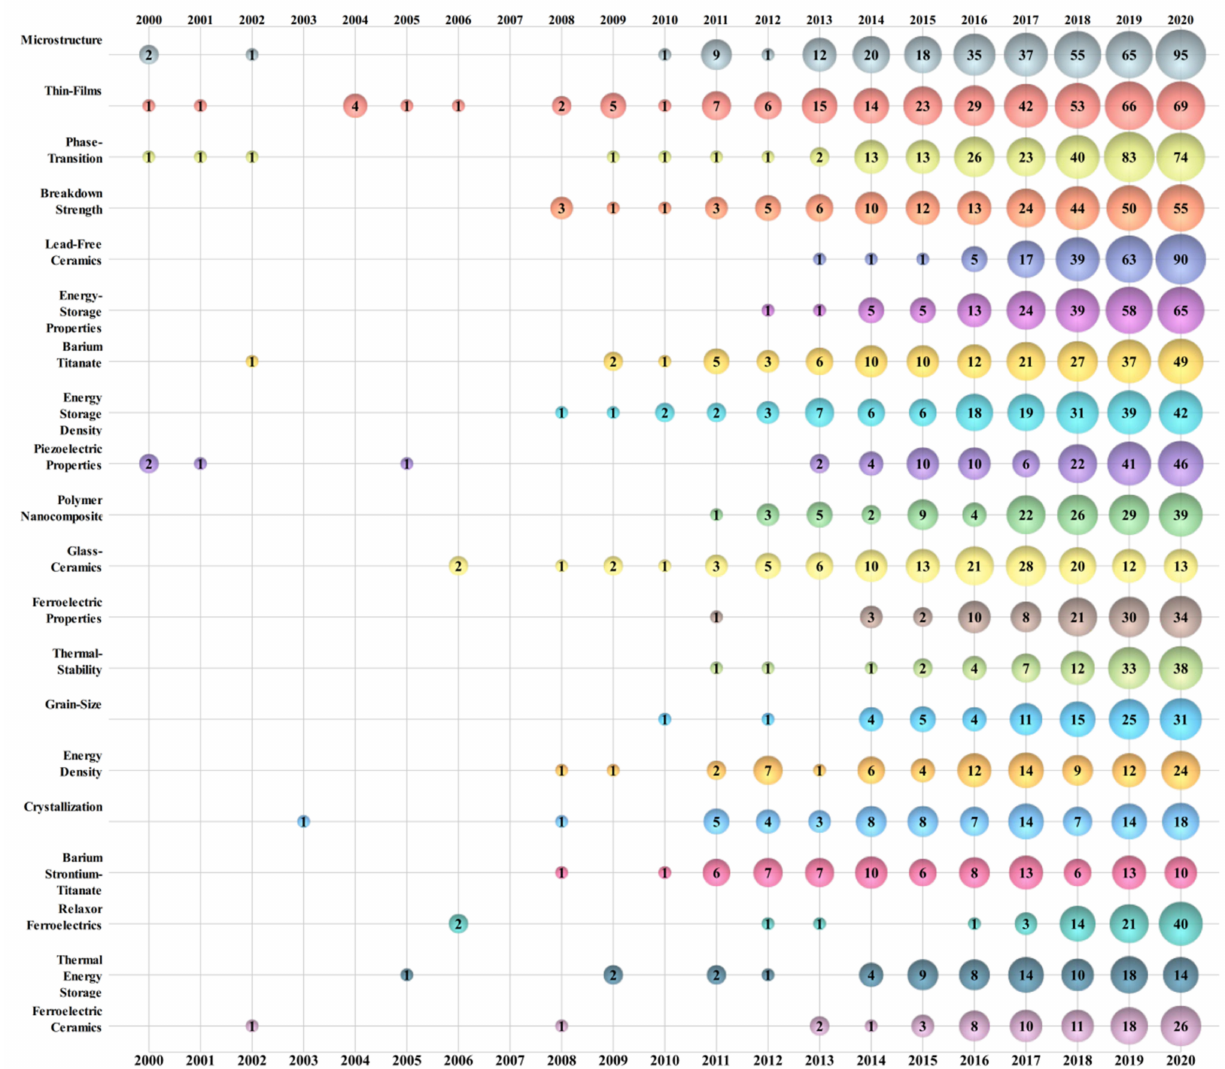
Figure 6 represents a map of energy storage ceramics research. A bubble chart was used to show the development trend of this field in 3D. Using the size of bubble as a third dimension, the chart can be applied to track research frontiers [59]. The number in a bubble represents the frequency of a keyword in that year.